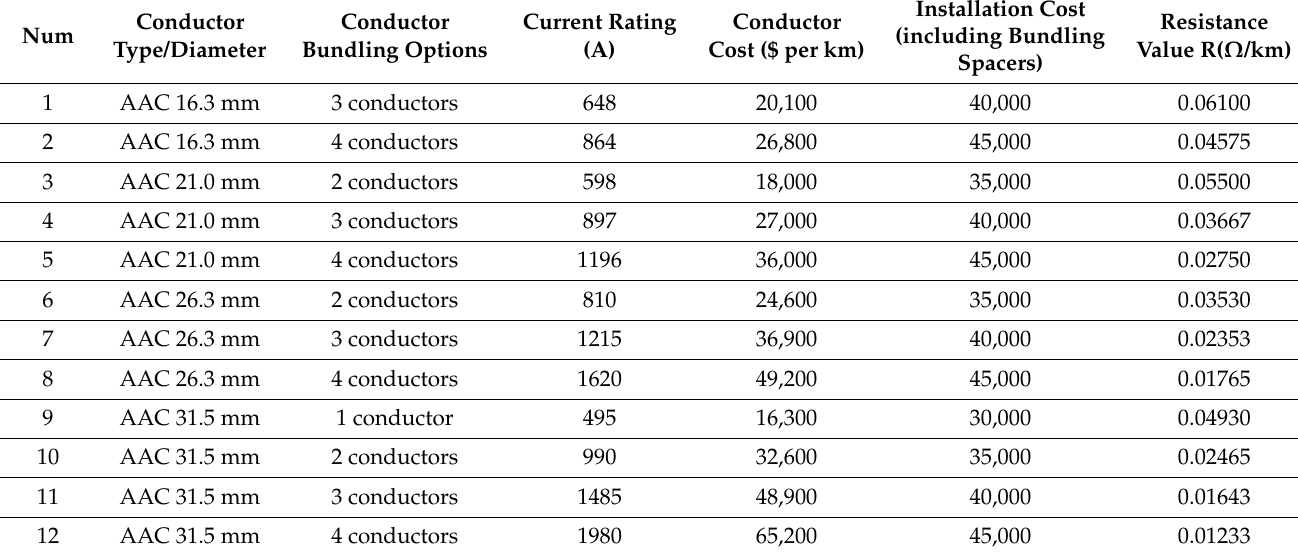
Table 3. Costs of different types of